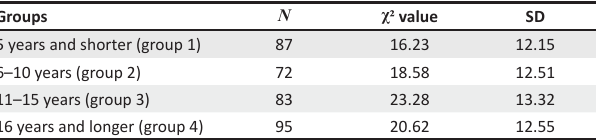
TABLE 9: Scheffé results for emotional exhaustion and experience as independent variables. Groups N χ² value